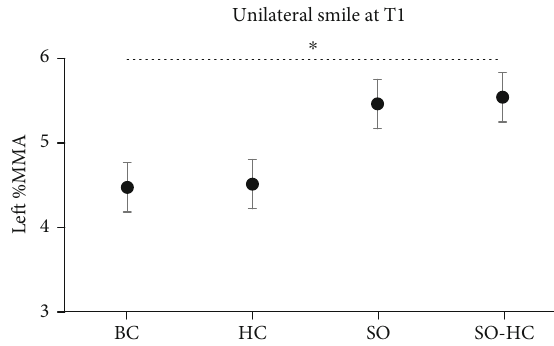
Figure 4: Results of unilateral task at T1. Left %MMA was the Euclidian distance in millimeters between the two lip corner markers expressed as a percentage of the MMA at baseline. All the experimental conditions are represented: smile observation followed by imitation of the same smile movement and ipsilateral hand contraction (SO-HC), smile observation followed by imitation of the same smile movement but without hand contraction (SO), no smile observation but hand contraction (HC), and no smile observation and no hand contraction (BC). Error bars represent SE (standard errors of the show a slight decrease ( T1 = 3 : 544 mm ± 0 : 28 , T2 = 2 : 39 mm ± 0 : 15 ; Figure 5(d)).